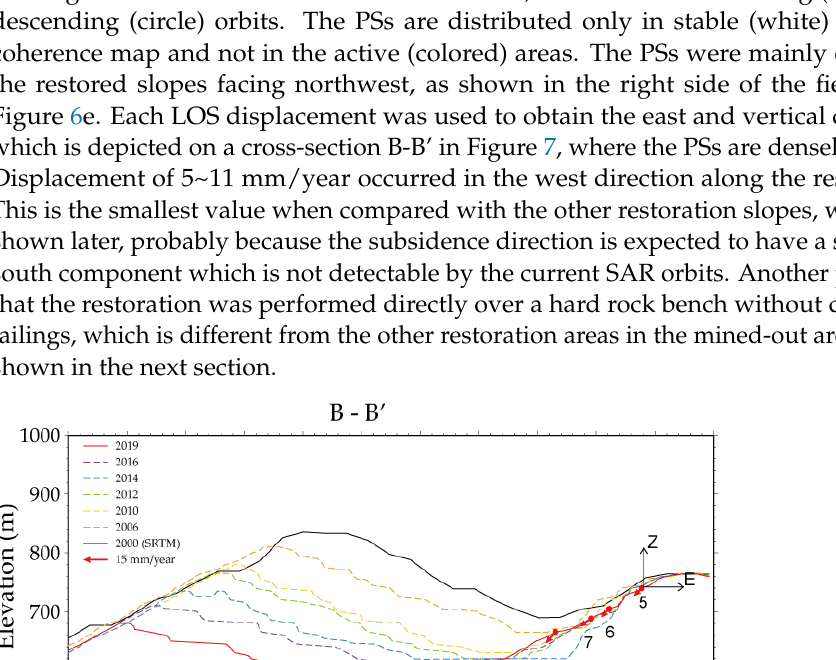
Figure 7. Elevation changes and displacements along the B-B’ cross-section in the mining area. Note the displacement arrows are in vertical-east plane. Except for SRTM, the rest of the DEM was obtained from the National Geographic Information Service of Korea.